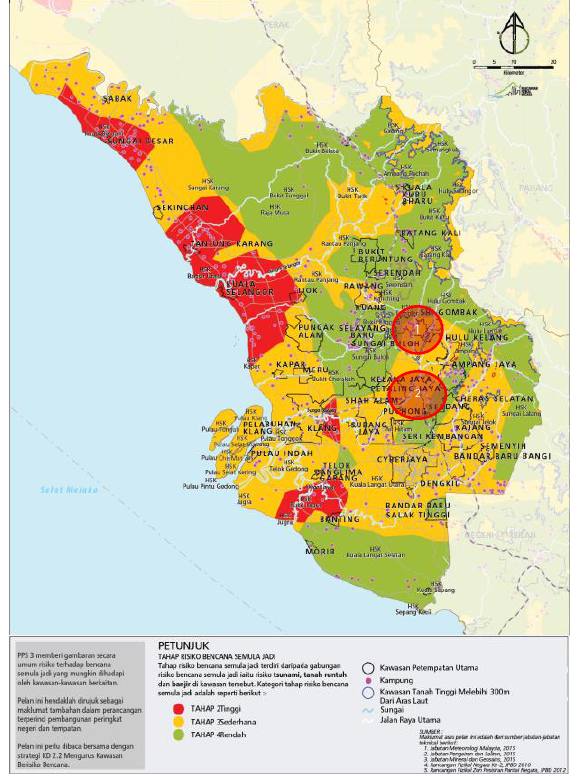
Figure 3: Level of disaster risk of the two study